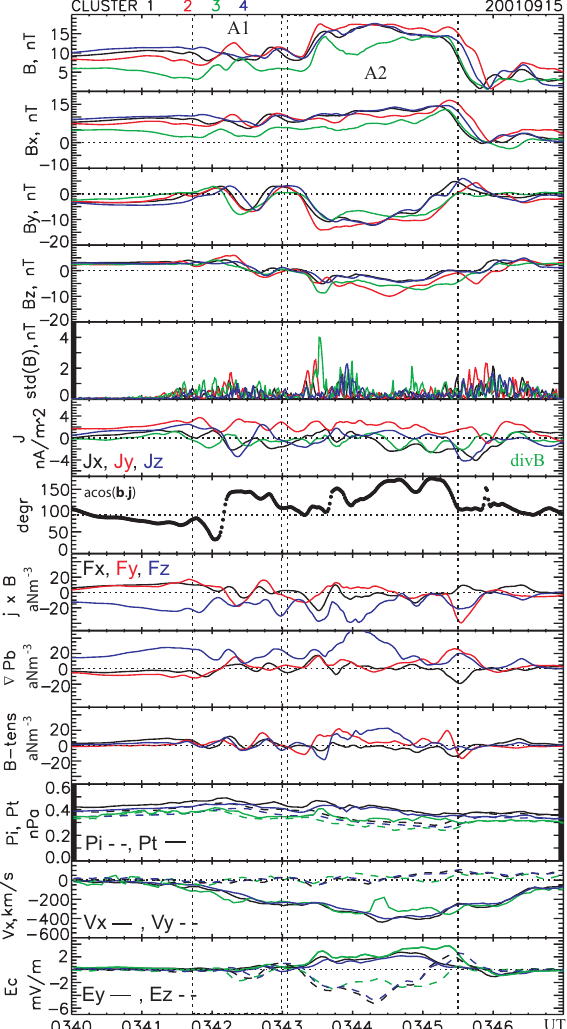
Fig. 4. Cluster observation during interval A . From top to bot- tom: Magnetic field magnitude; X , Y , and Z components of the magnetic field at the four spacecraft; standard deviation of B ; X , Y , and Z components of the electric current density j = µ − 1 angle between j and B ; X , Y , and Z components of the j × B force, magnetic pressure gradient and magnetic field tensions; ion and to- tal pressures; X and Y components of the ion bulk velocity; and Y and Z components of the E c =− V × B electric field. The GSM coordinate system is used for